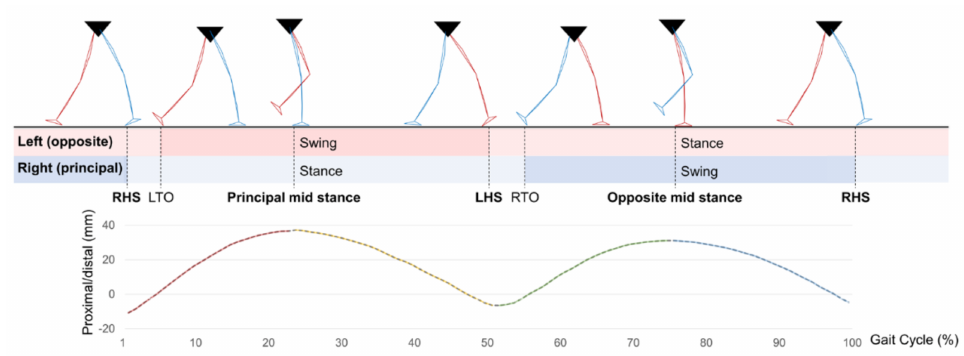
Figure 5. Description of four gait phases. A gait cycle is separated into four phases based on the proximal/distal movement of the CG (RHS: Right heel strike, LTO: Left toe − off, LHS: Left heel strike, RTO: Right toe − off).